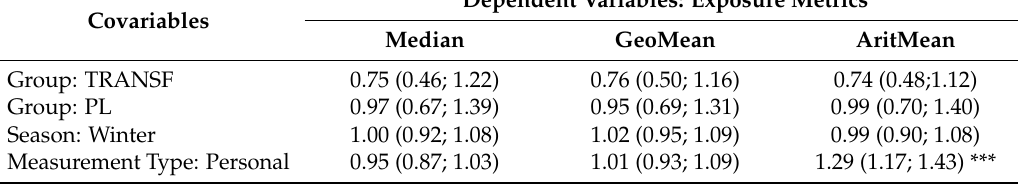
Table 4. Model coefficients of the chosen variables (study group, season, and measurement type) for the target variables (median, geometric mean, and arithmetic mean). Dependent Variables: Exposure Metrics Covariables